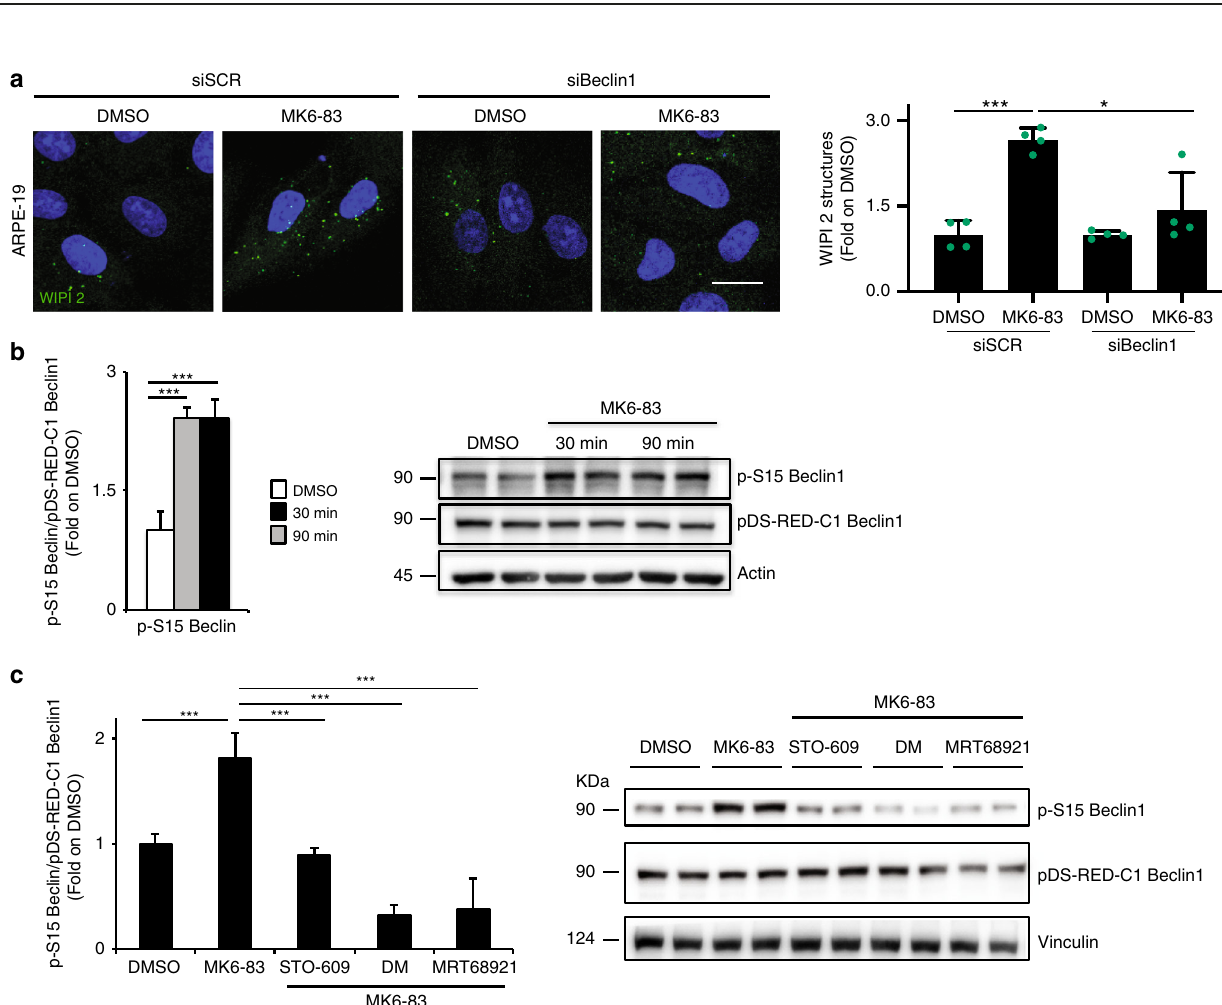
Fig. 5 Pharmacological activation of TRPML1 enhances Beclin1 S15 phosphorylation through the CaMKK/AMPK/ULK signaling pathway. a Representative confocal images of endogenous WIPI2 in ARPE-19 cells treated with with a pool of three siRNA molecules targeting Beclin1 (siBeclin) followed by treatment with MK6-83. Plot shows the quanti fi cation of WIPI2-positive puncta as fold induction to DMSO-treated cells. Values are means ± SD of n = 616 cells pooled from three independent experiments. b Representative image of immunoblot analysis of phosphorylation of pDS-RED-C1-Beclin1 on serine 15 upon MK6-83 treatment at 30 and 90 min. Plot shows the densitometry of p-Beclin1 S15 on pDS-RED-C1-Beclin1 normalized on Vinculin as fold induction to DMSO-treated cells. The data in the graphs on the left are mean values ± SD, n = 6 lysates per condition pooled from three independent experiments. c Representative image of immunoblot analysis of phosphorylation of pDS-RED-C1-Beclin1 on serine 15 upon MK6-83 treatment alone or in combination with STO-609, dorsomorphin (DM), or MRT-68921. The data in the graphs on the left are mean values± SD, n = 6 lysates per condition pooled from three independent experiments. P -values calculated by two tails Student ’ s t -test. Scale bar: 20 µ m. * p -value < 0.05; ** p -value < 0.01; *** p -value <